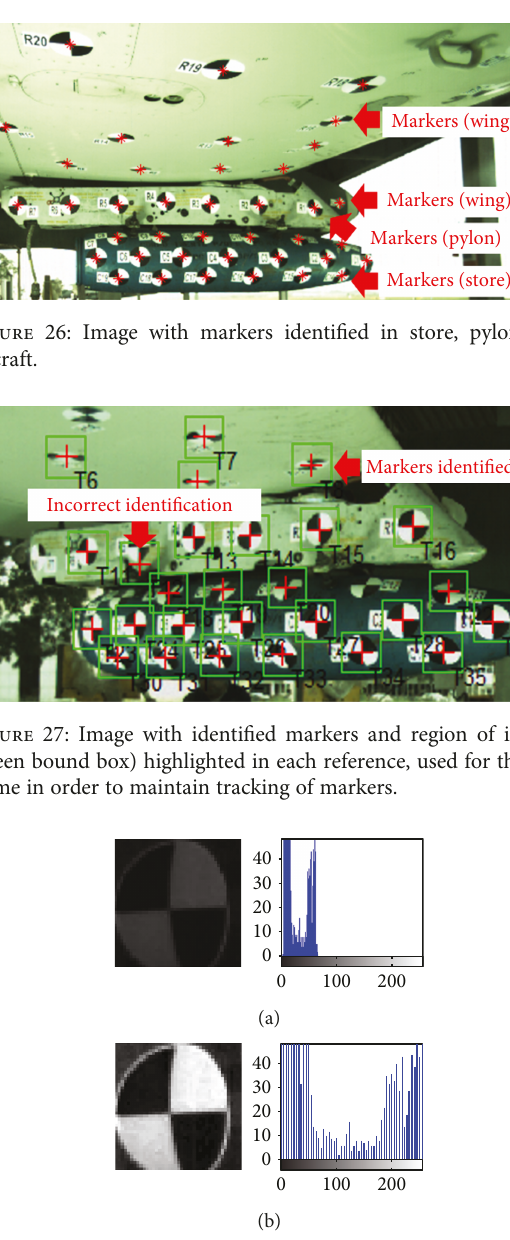
Figure 28: (a) Example of a marker and its histogram and the (b) marker after equalization of the histogram.